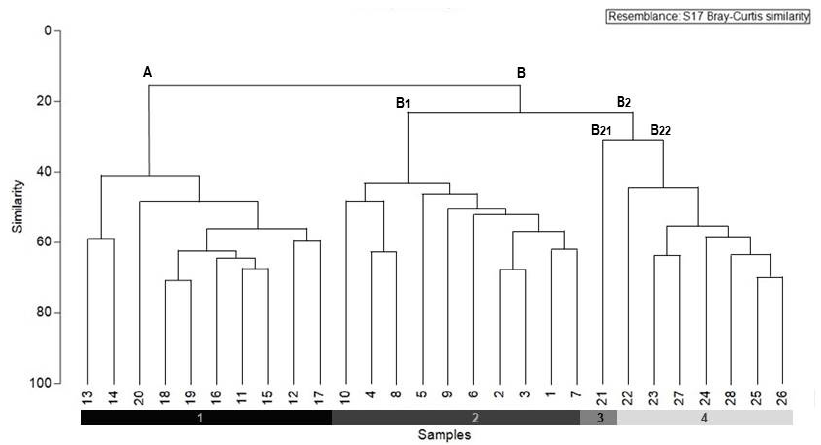
Figure 2. Classification analysis (UPGMA clustering dendrogram, with Bray-Curtis distance): Group A includes 1— Myrto communis-Quercetum rotundifoliae (11–20); Group B includes 2— Ulici argentei- Quercetum rotundifoliae (B1; 1–10), 3— Rhamno oleoidis-Quercetum rotundifoliae (B21; 21) and 4— Rhamno laderoi-Quercetum rotundifoliae (B22;